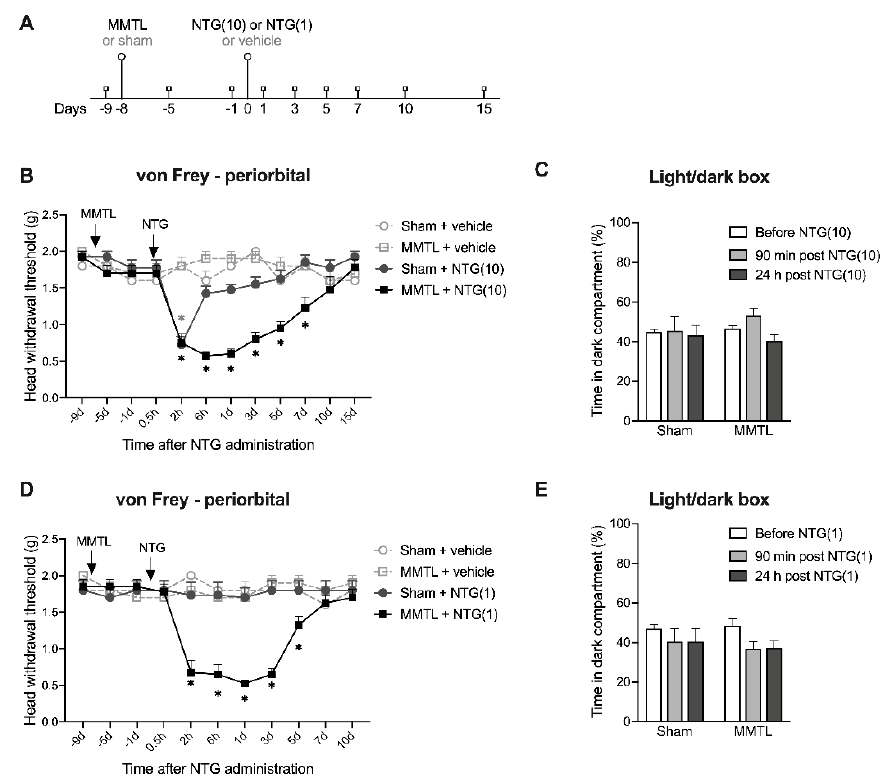
Figure 3. MMTL enhances NTG ‐ induced migraine ‐ like hypersensitivity. ( A ) Timeline of this experiment. ( B ) MMTL pretreatment prolonged the higher dose (10 mg/kg) of NTG ‐ decreased head